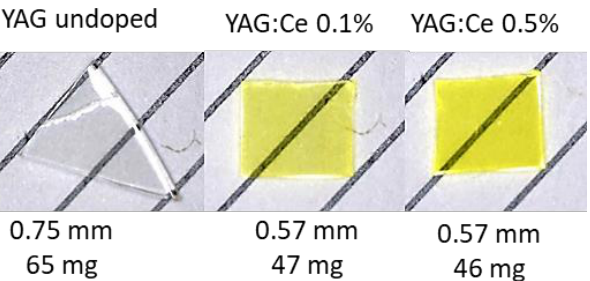
Figure 1. The pictures of the studied YAG crystals, with the data on thickness and mass of the samples. The distance between lines in the background is 3 mm.